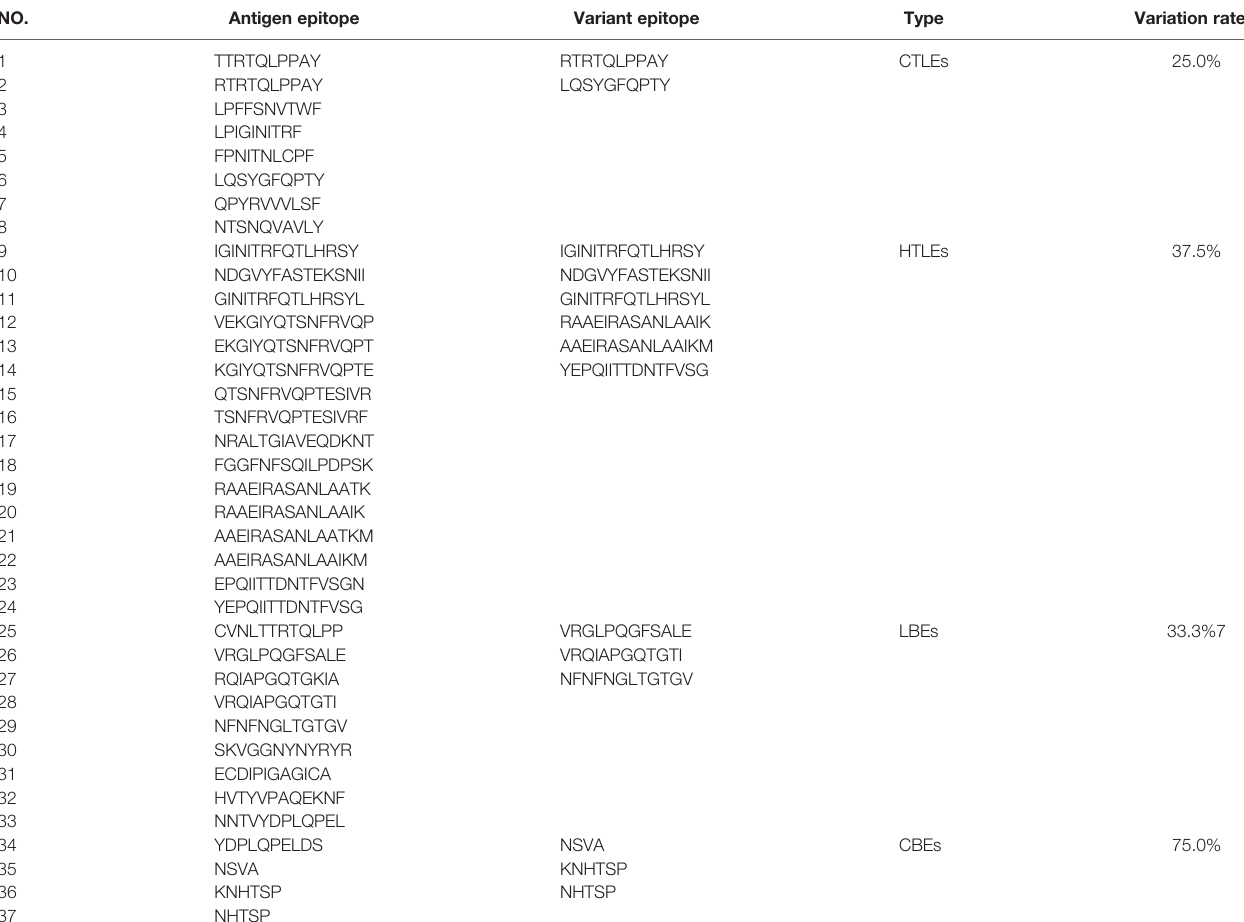
TABLE 2 | The antigen epitopes for vaccine construction.